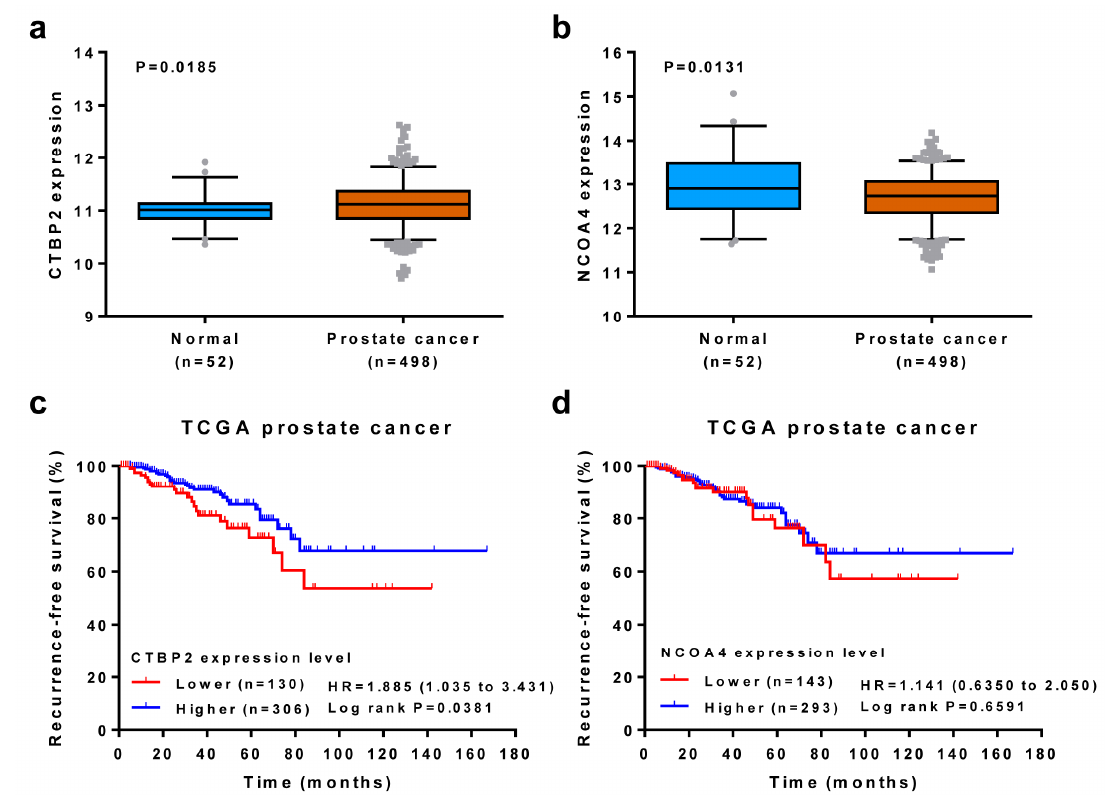
Figure 6. Clinical association of CTBP2 and NCOA4 in TCGA dataset. ( a,b ) Gene expression di ff erence between normal and prostate cancer were determined using Mann–Whitney test. The upper, middle, and lower bounds of boxes represent the 75th, 50th, and 25th percentile of the values, respectively. The whiskers represent 95th to 5th percentile. ( c,d ) Association of recurrence-free survival (RFS) with gene expression was evaluated using log-rank